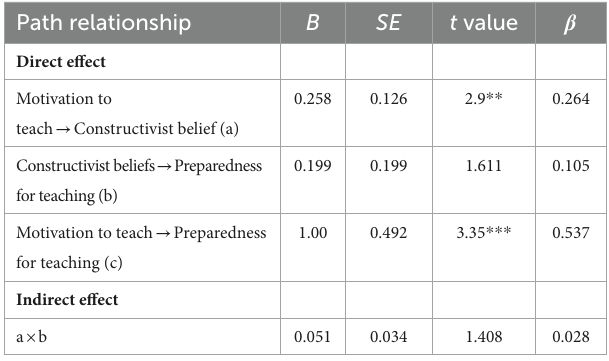
TABLE 4 Structural equation model path